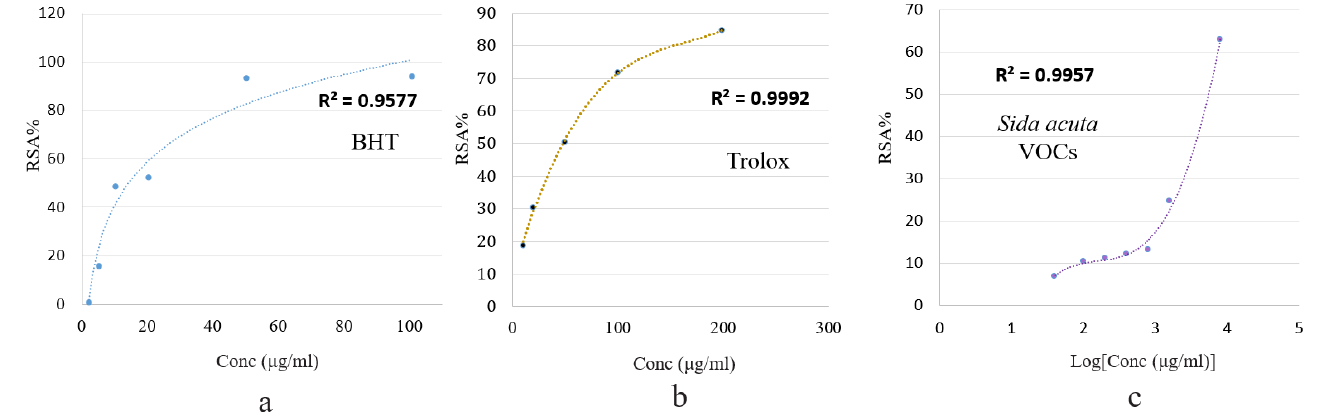
Figure 3. Percentage of radical scavenging activity (RSA%) of BHT ( a ), Trolox ( b ), and S. rhombifolia volatile organic compounds ( c ), by the DPPH method.